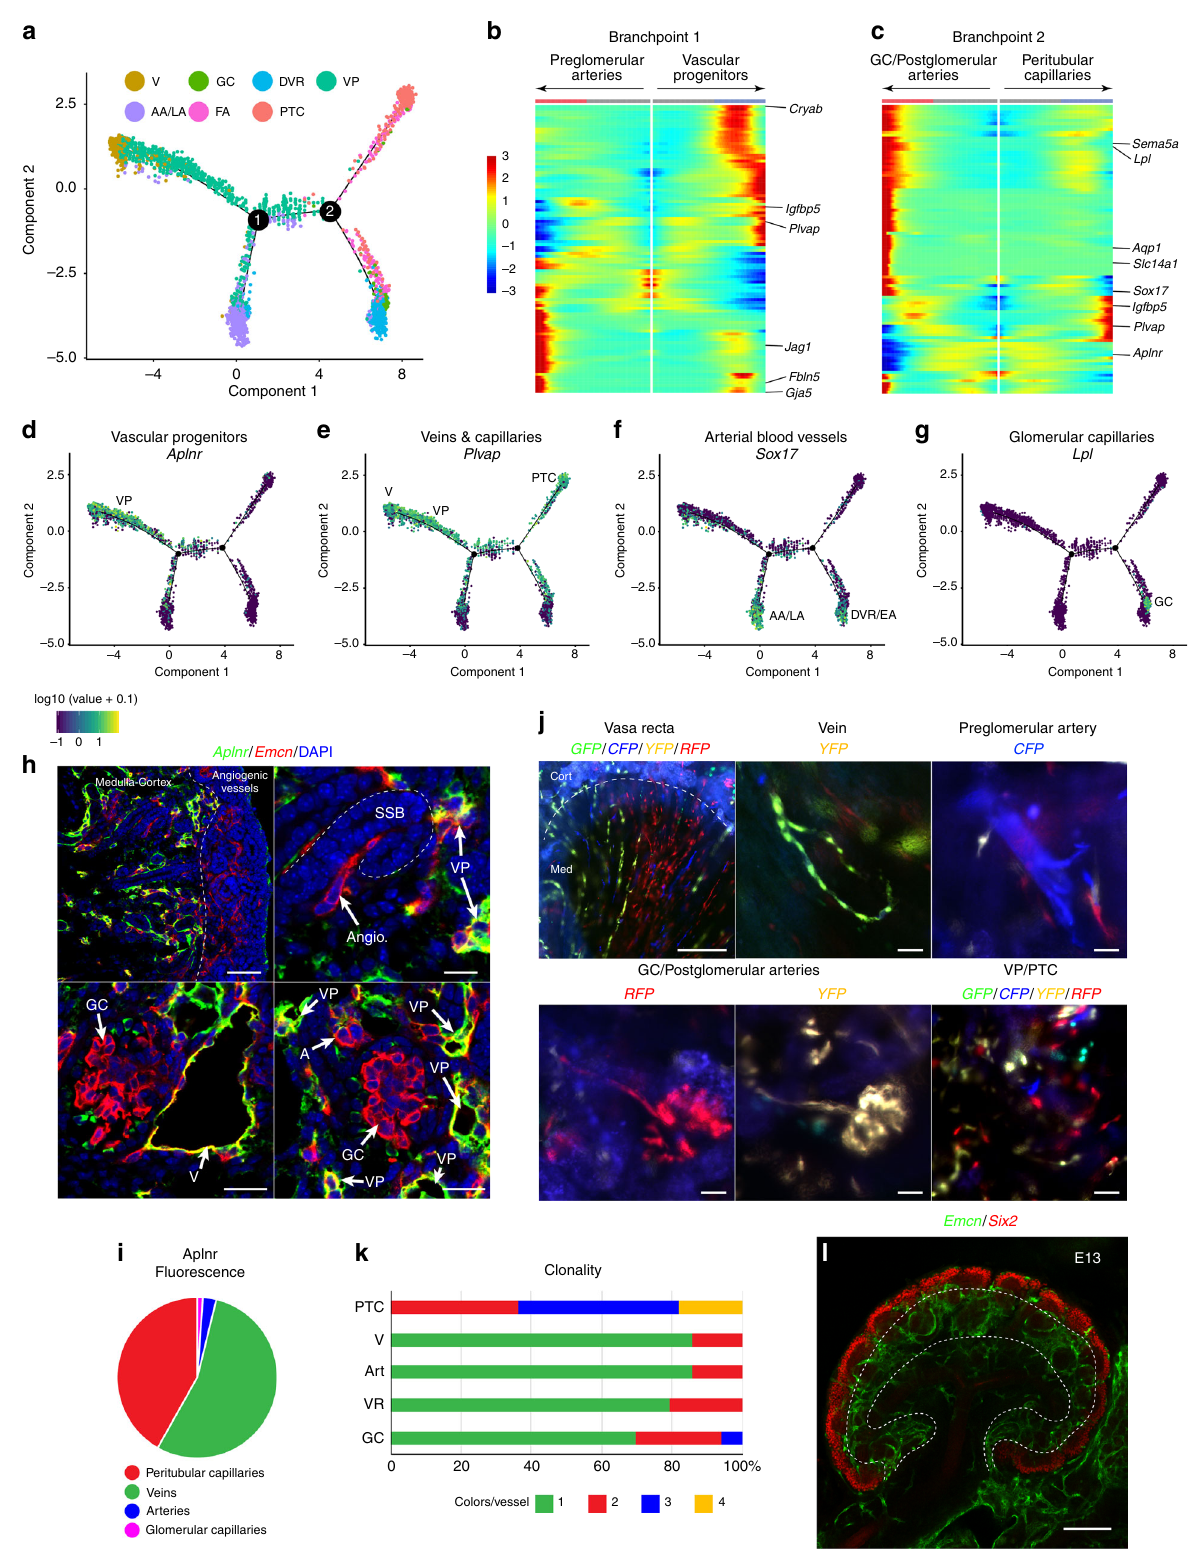
We de fi ned 617 transporter proteins, 1314 transcription factors, and 2032 secreted proteins, from the transporter classi- fi cation database (http://www.tcdb.org/), the DBD transcription factor prediction database 26 , and the human protein atlas (https://www.proteinatlas.org/). We fi nd sets of genes